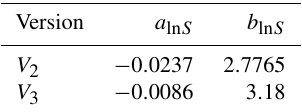
Table 1. Coefficients used in the parameterization of the a priori value of S .